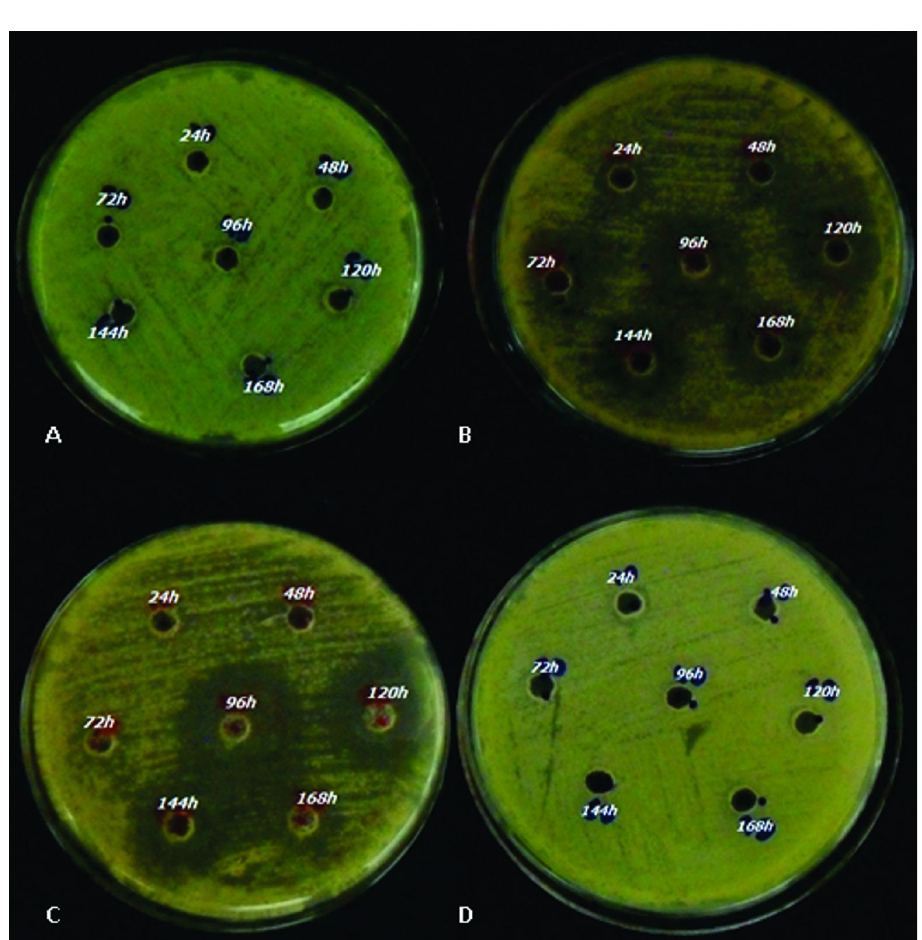
FIGURE 2 - Anti- Candida activity of fermented liquid Streptomyces sp. MPO-4 against Candida albicans . A) Fermented liquid ISP2 without stirring; B) Fermented liquid ISP2 with stirring; C) Fermented liquid ISP2 modified with stirring; D) Fermented liquid ISP2 modified without stirring.